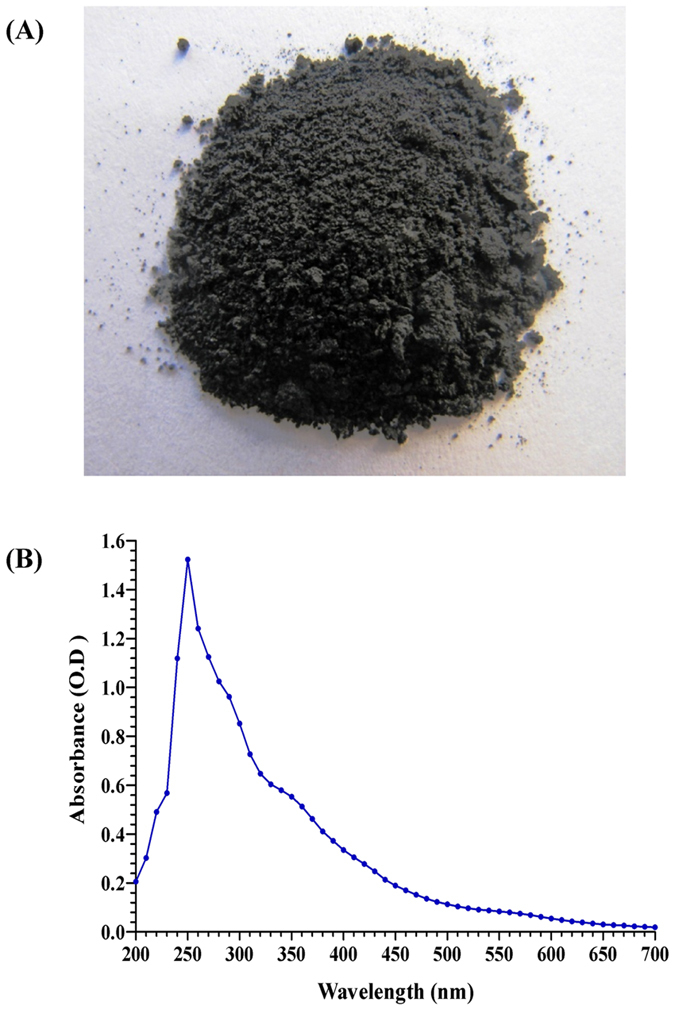
(A) Granules of extracted lyophilized melanin; (B) UV-visible absorbance spectrum (200–700 nm) of the purified melanin pigment of Streptomyces glaucescens strain NEAE-H.